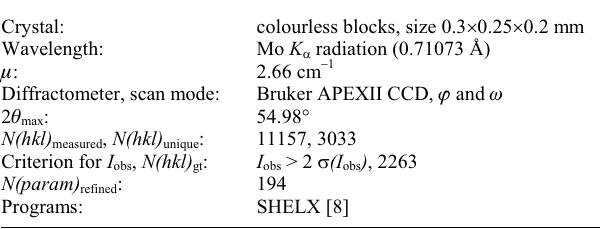
Table 1. Data collection and handling.